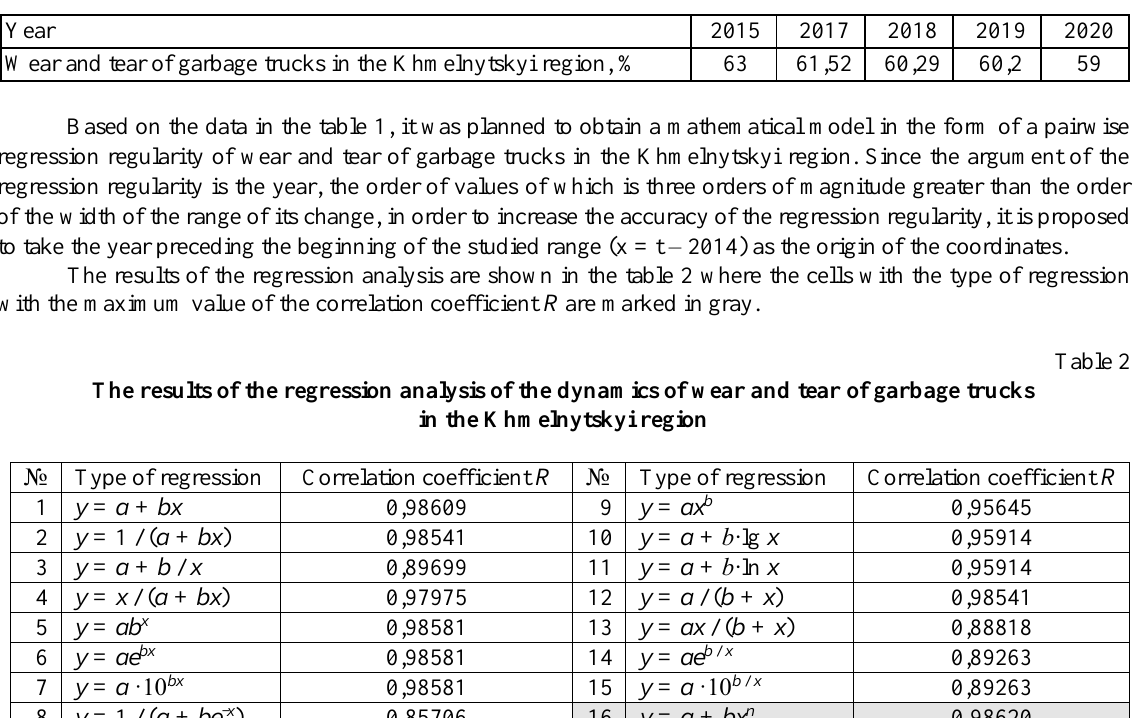
Statistical data for 2015-2020 on the dynamics of wear and tear of garbage trucks